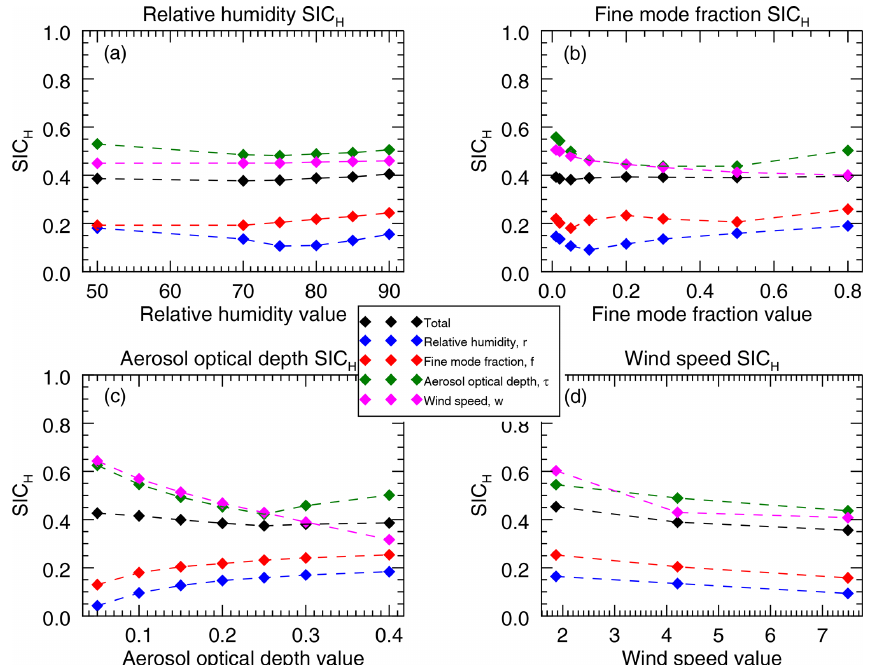
Figure 8. Median SIC H for total (black), r (blue), f (red), τ (green), and w (magenta) values, parsed by parameter value. Panel (a) shows sensitivity to r , (b) to f , (c) to τ , and (d) to w